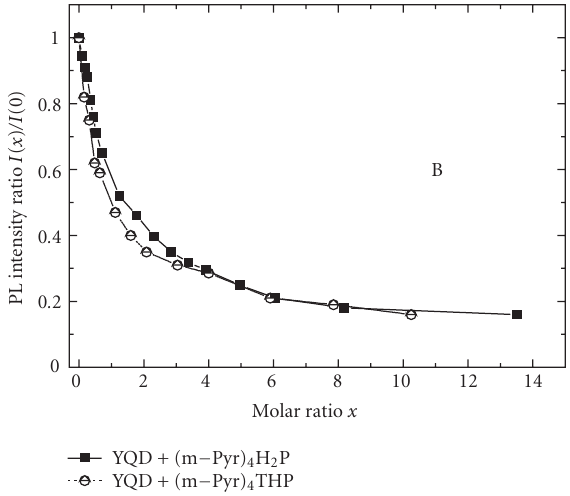
Figure 7: Comparison of PL quenching of YQD for (m − Pyr) 4 H 2 P and (m − Pyr) 4 THP as a function of the molar ratio ( x